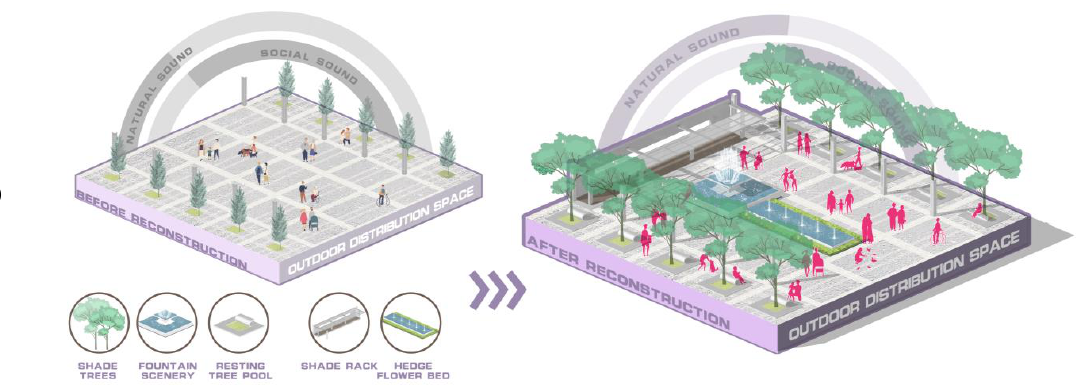
Figure 10. Optimum design strategies: ( a ) design with a fountain background wall and tall trees to attract birds and decrease acoustic discomfort; ( b ) design with uneven green land, safety exercise boundaries, and vegetation to dampen crowd noise influences; ( c ) increase the duration and frequency of broadcasting music to create comfortable outdoor rest space; ( d ) design with an ecological drought stream or rainwater garden to increase wind (a gentle breeze) and insects and running water and birdsong; ( e ) design with foundations, pools, flower beds, and corridors to improve the overall comfort and satisfaction.